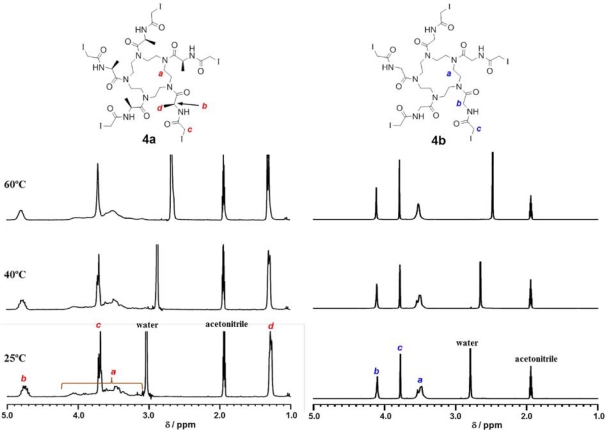
1H-NMR spectra of pentagonal iodoacetoamidated core molecules (4a and 4b) at 2.8 mM in mixture of CD3CN/D2O = 15/1.